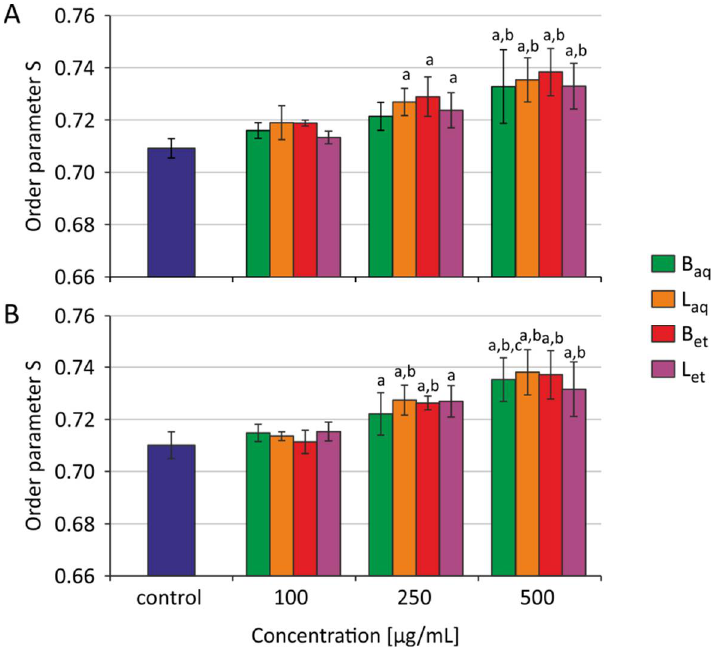
Figure 1. Order parameter S for erythrocytes incubated with extracts from U. tomentosa after 2 h ( A ) and 24 h ( B ) (B aq –aqueous extract from the bark, L aq –aqueous extract from leaves, B et –ethanolic extract from the bark, L et –ethanolic extract from leaves); a p < 0.05 vs. control, b p < 0.01 vs. control.